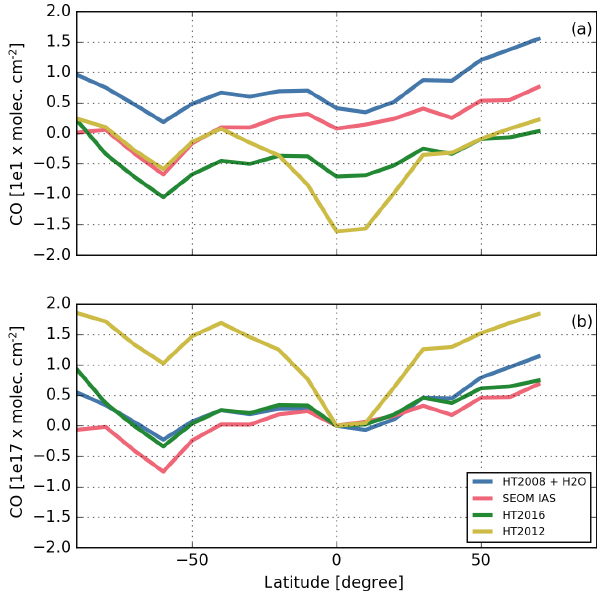
Figure 6. (a) Longitudinally averaged difference between TROPOMI and CAMS-IFS model data for 10 October 2018 (TROPOMI-CAMS-IFS). The CAMS-IFS model are spatiotempo- rally interpolated to the TROPOMI measurements and averaging kernels are applied. The colors indicate the bias when using differ- ent spectroscopic databases in the TROPOMI retrieval. Panel (b) is the same as (a) but relative to the corresponding difference at 0 ◦ latitude to visualize the different gradients in